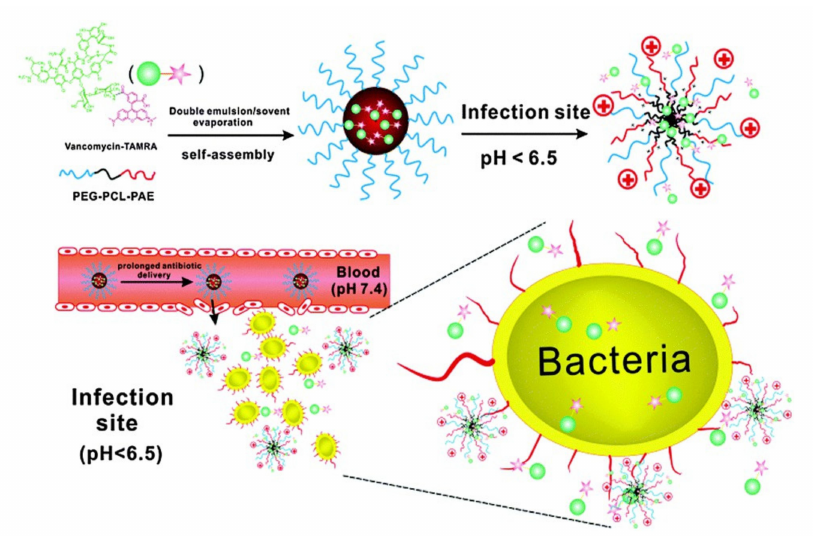
Figure 8. Schematic illustration of a charge-adaptive nano-system for prolonged and enhanced in vivo antibiotic delivery. These nanocarriers are designed to shield unspecific interactions during circulation at pH 7.4 but bind avidly to bacteria in acidity, enhancing antibiotic delivery (reproduced with permission from [62], copyright 2016 Royal Society of